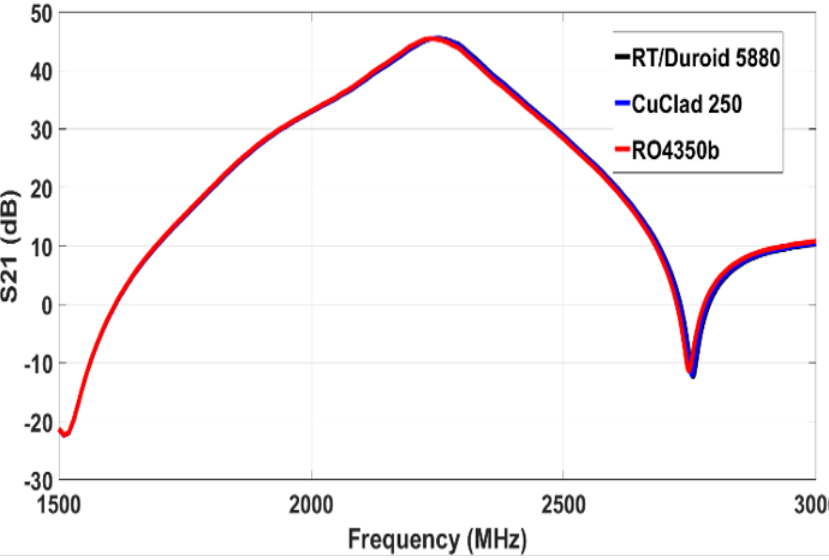
Figure 8. Forward transmission parameter (S 21 ) simulation for the selected RF substrates centered at 2.25 GHz.